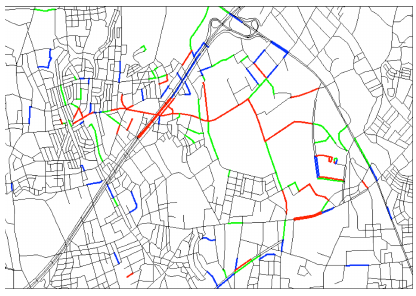
Figure 10. Usage frequency of each link in Chiba